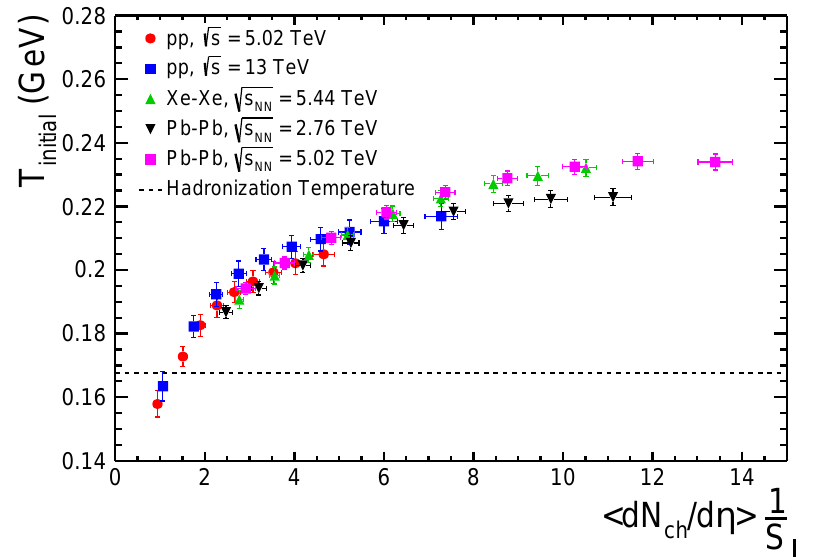
Figure 2. Initial percolation temperature vs. (cid:104) dN ch / d η (cid:105) , scaled by S ⊥ , from pp , Pb-Pb and Xe-Xe collisions. The line ∼ 167.7 MeV is the universal hadronization temperature